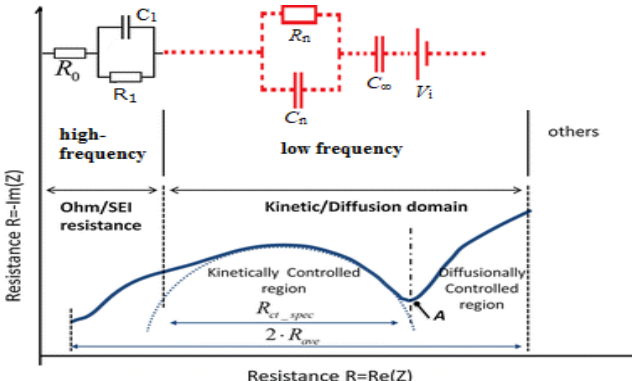
Figure 12. Relation of variables in the frequency response with a physical meaning.